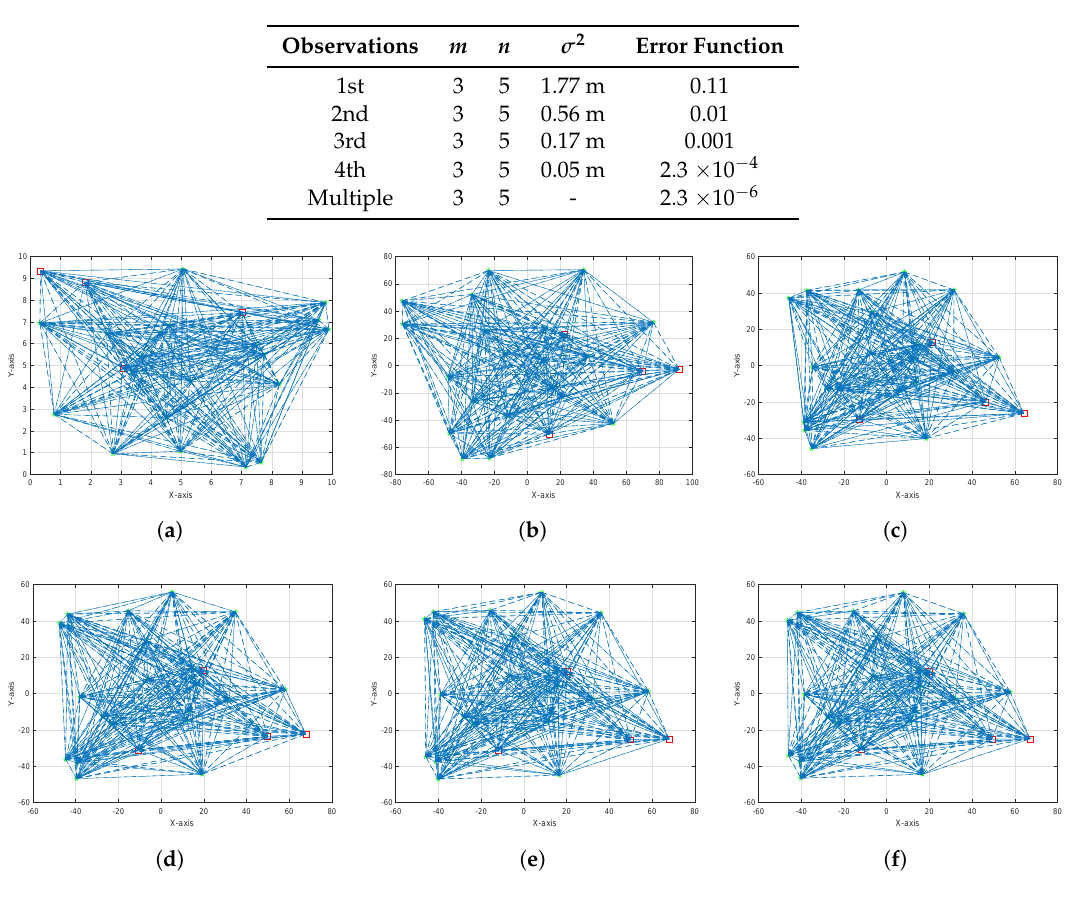
Table 3. Parameters setup and error function comparison for the first scenario.